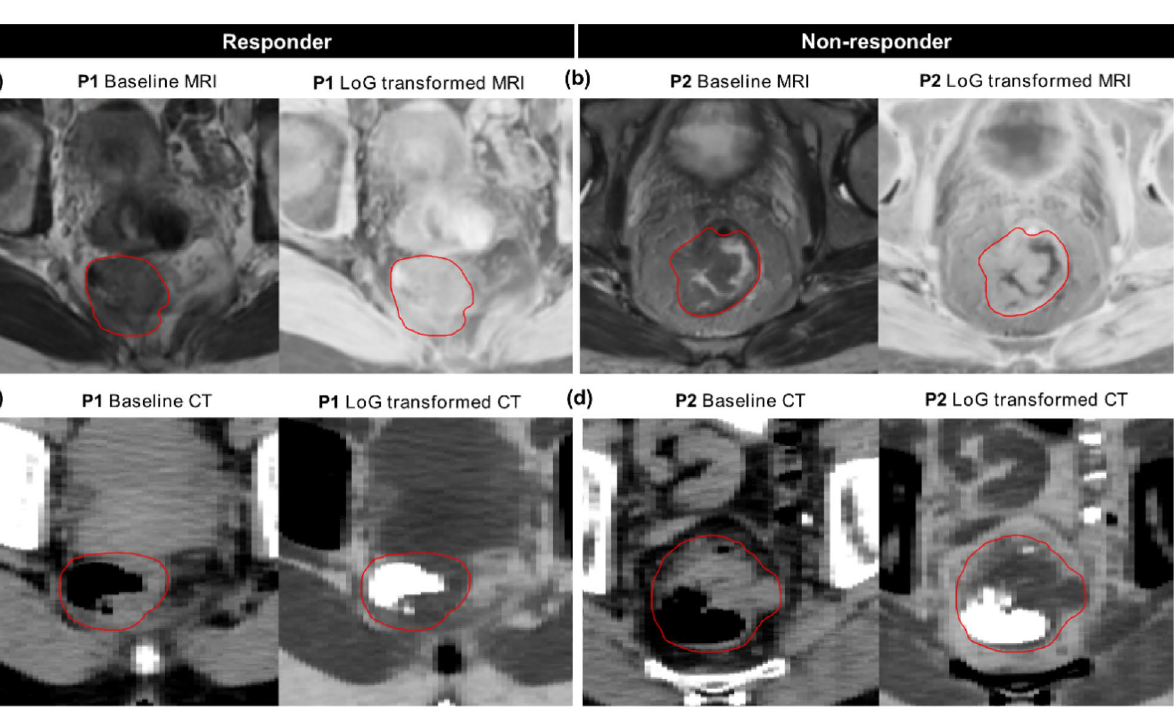
Figure 3. Representative images from MRI ( a , b ) and CT ( c , d ) with corresponding Laplacian of Gaussian (LoG) transformed images from two patients (P) in the two response groups, i.e. responder: P1 and non-responder: P2 on the training data. Red contours mark the gross tumour volume (GTV). P1 (responder: TRG = 4) showed an overall homogenous appearance on the baseline MRI. On the contrary, P2 (non-responder: TRG = 1) showed a more heterogeneous GTV with a low stat_min value on the LoG transformed MR image, which corresponds to some high pixel intensities on the baseline MRI. Similarly, a more homogenous GTV (excluding the air voxels) can be seen in P1 compared to P2 on the baseline and LoG transformed CT slices, possibly causing low gradients in the intensity histogram for the